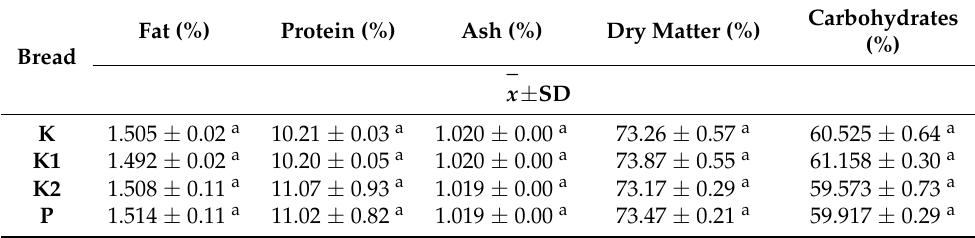
Table 2. Chemical composition (mean ± standard deviation) of the bread with S. cerevisiae sup- plemented with magnesium ions in 100 g of the final product. Control samples of the bread with yeast: K, dry yeast; K1, without magnesium and PEF treatment; K2, with magnesium and without PEF